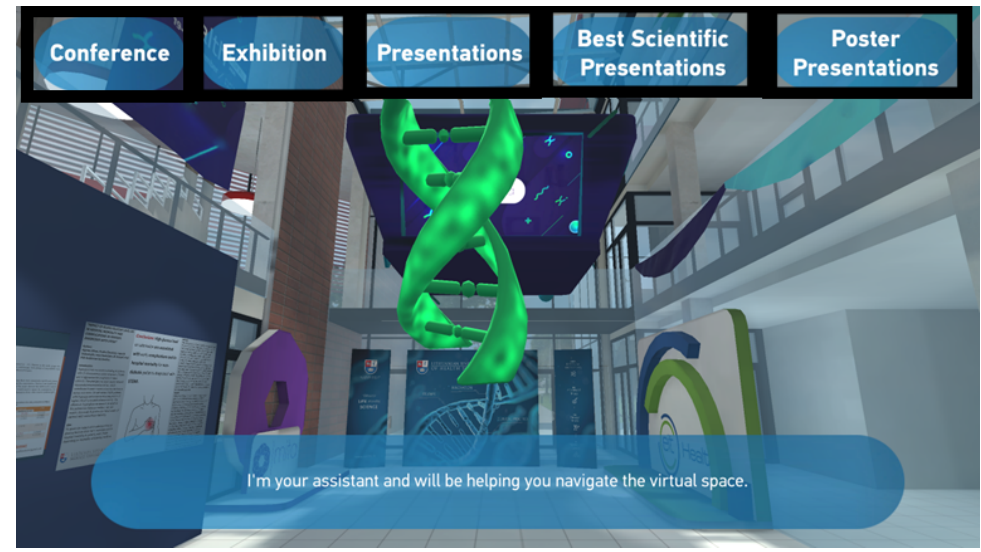
Figure 5. An example of the VR interface. Black frames show the tasks as defined by the UI layout given in Figure